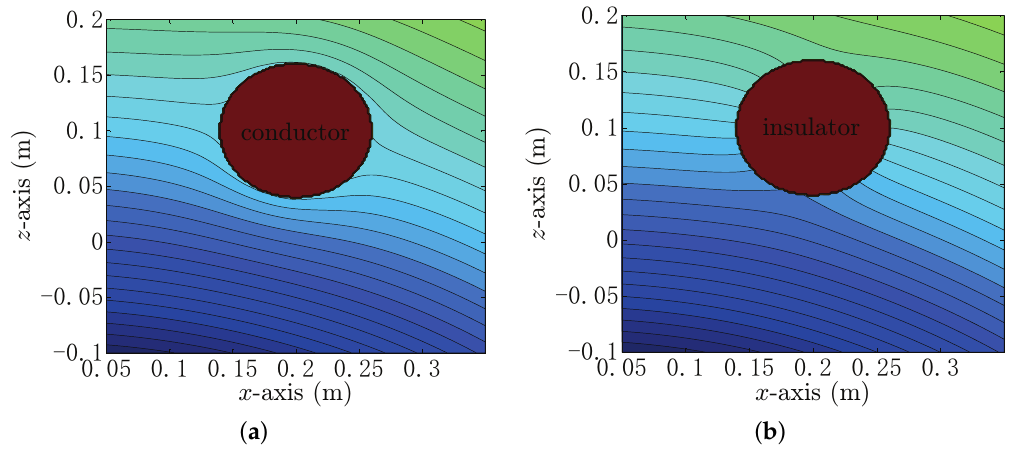
Figure 1. ( a ) An example of the potential distribution distorted by the spherical metallic target; ( b ) an example of the potential distribution distorted by the spherical insulator